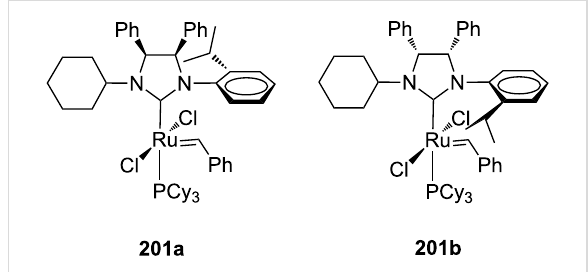
Figure 36: Enantiopure catalysts 201a and 201b with syn phenyl units on the NHC backbone. Ruthenium catalysts coordinated with backbone monosubstituted N -aryl, N’- aryl NHCs